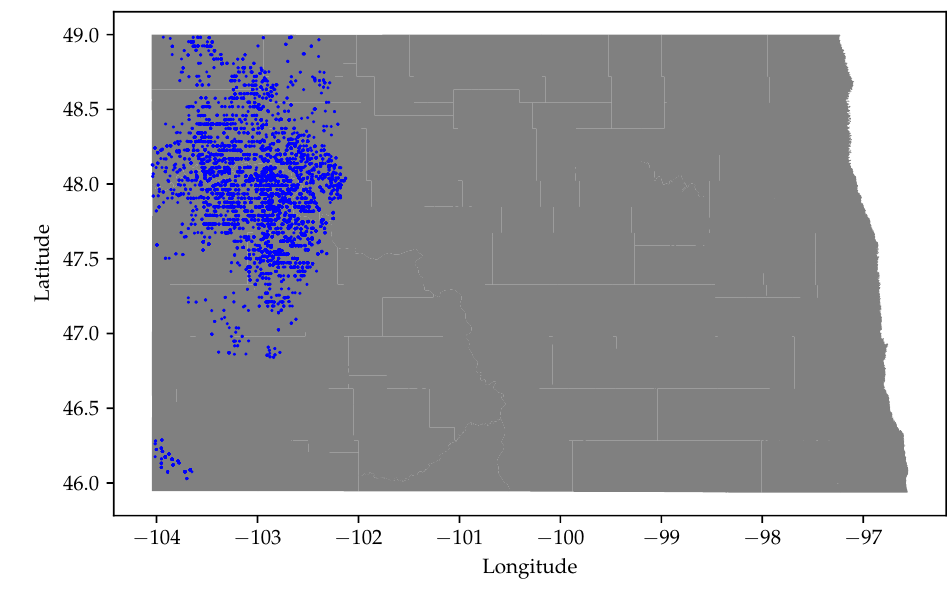
( a ) North Dakota county shapes (gray) overlaid with VIIRS flare locations (blue).